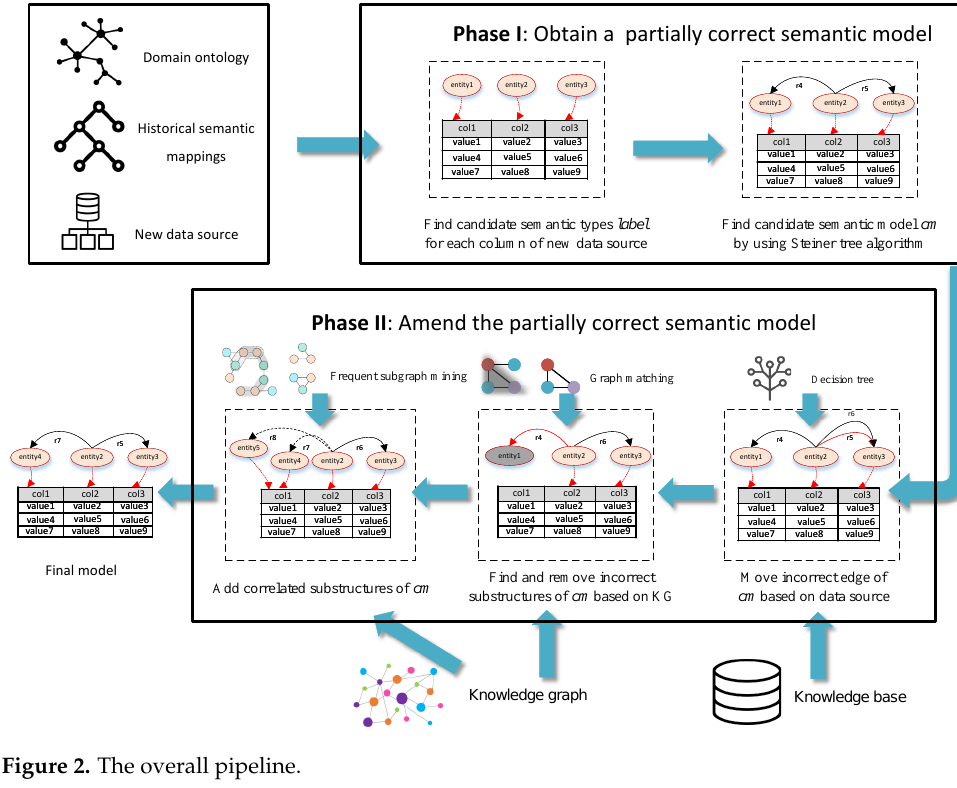
Figure 2. The overall